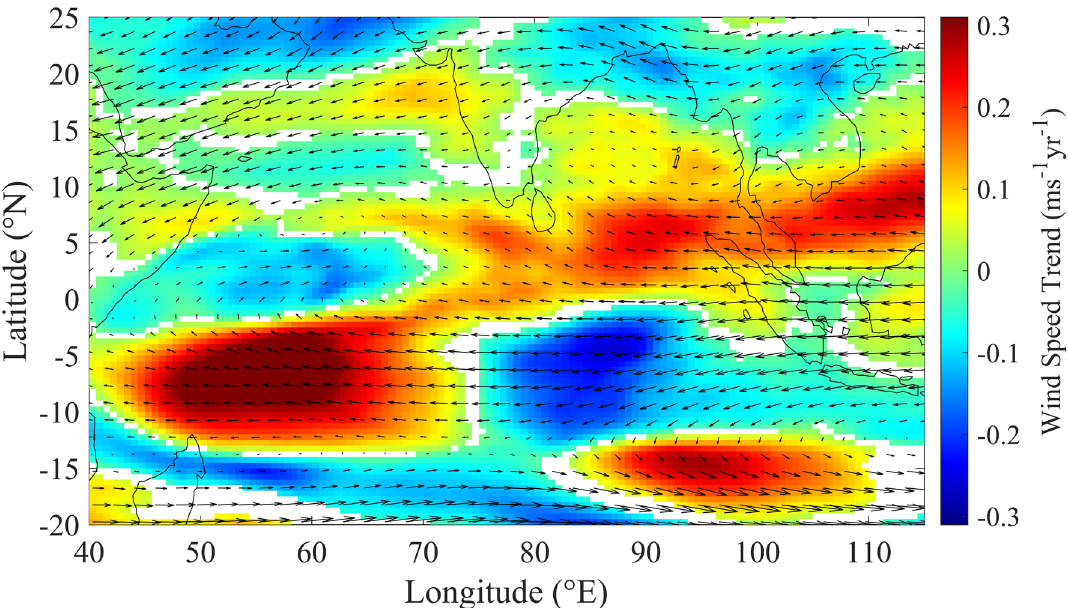
Figure 4. Trends of horizontal winds at 450–350 hPa: Trends of horizontal wind speed (represented by color) at altitudes of 450 to 350 hPa, in the month of August during 2000–2017, excluding the years of El Niño and La Niña conditions. Black arrows embedded in the figure indicate the mean wind pattern during the same period. Positive (negative) values indicated by colors show the regions where winds are strengthening (weakening), whereas white patches show the regions where trends are not statistically significant at 95% confidence level. The map is generated using MATLAB 2020a, www. mathw orks.